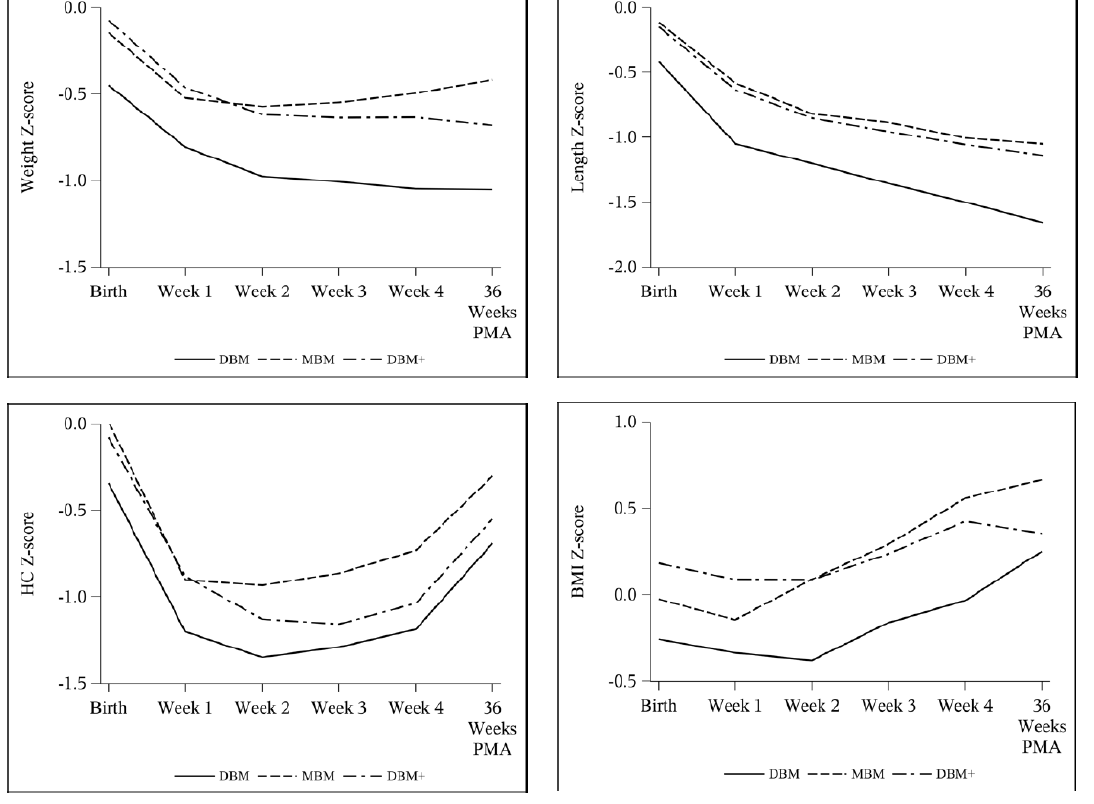
Figure 2. Weekly mean Fenton z-score for weight, length, and HC and Olsen z-score for BMI by cohort: DBM ( n = 58), MBM ( n = 64), DBM+ ( n = 59).